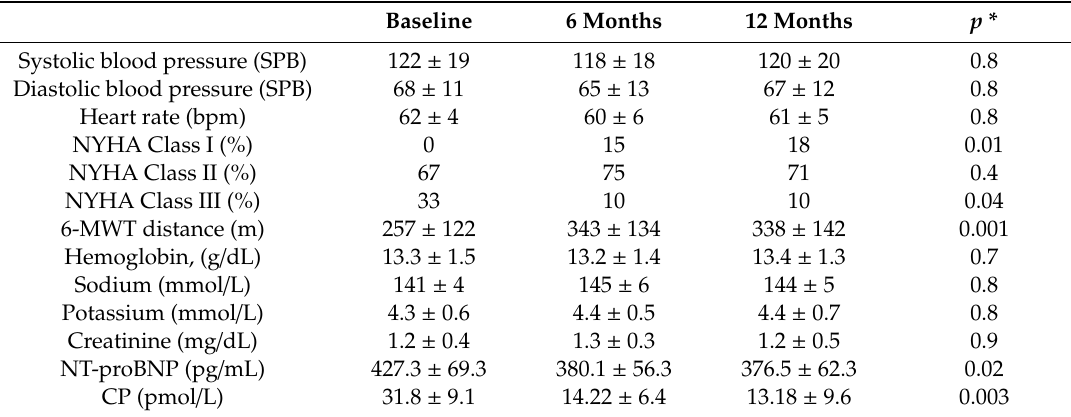
Table 2. Clinical and laboratory values at baseline and over time.